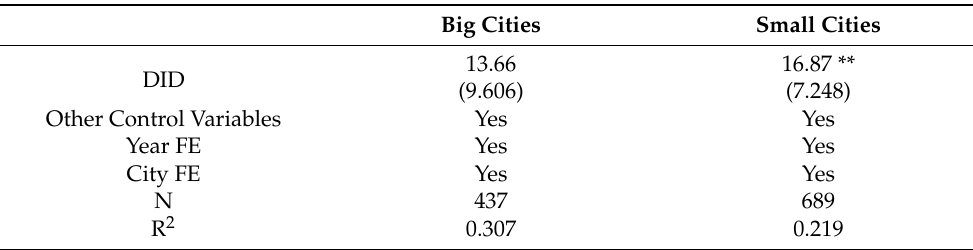
Table 6. Heterogeneity Analysis.